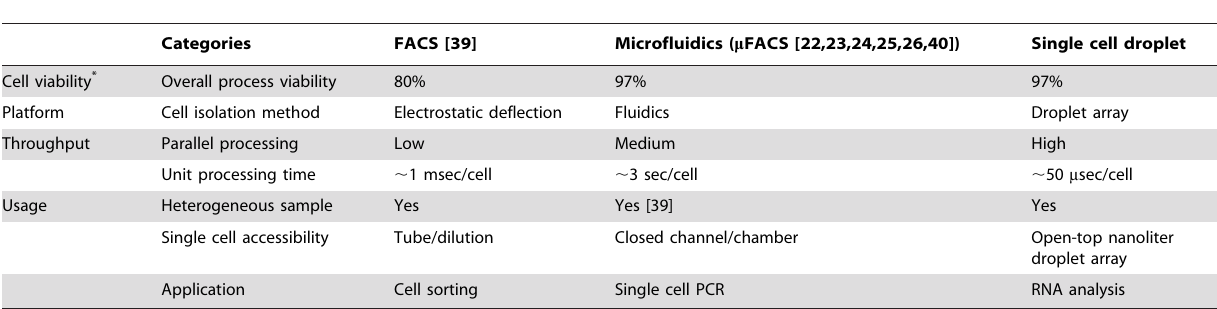
Table 1. Performance comparison with conventional methods: isolating single cell’s from a heterogeneous cell